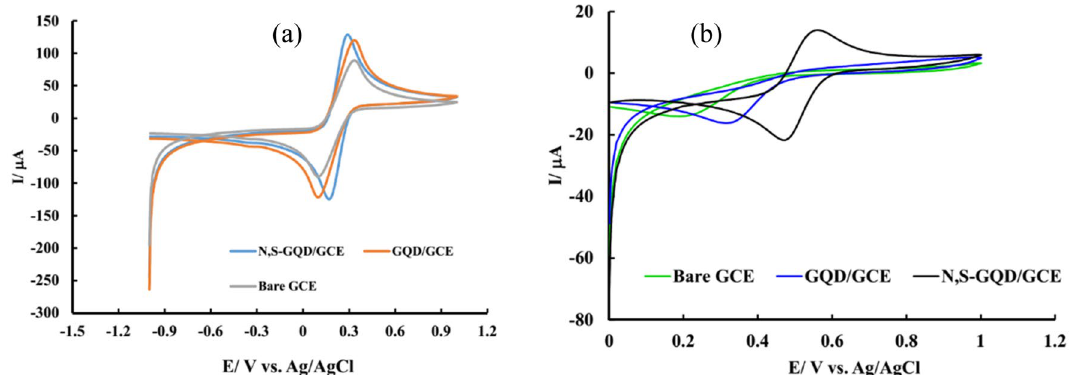
Figure 5. Cyclic voltammograms of bare, and modified electrodes ( a) in 5 mM Fe(CN) 63− /Fe(CN) 64− solution containing 0.1 M KCl and ( b ) in 0.5 M KNO 3 containing 25 µM